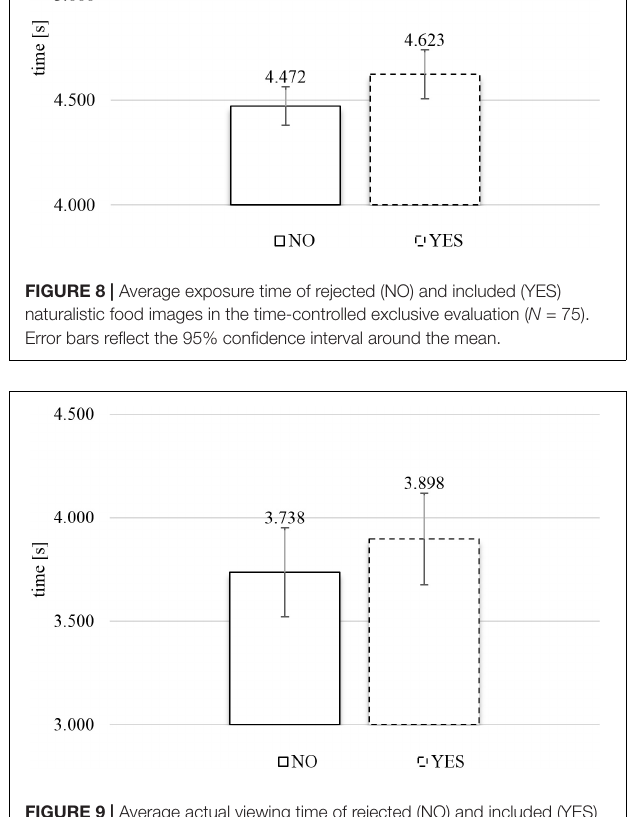
FIGURE 9 | Average actual viewing time of rejected (NO) and included (YES) images in the time-controlled exclusive evaluation ( N = 41). Error bars reflect the 95% confidence interval around the